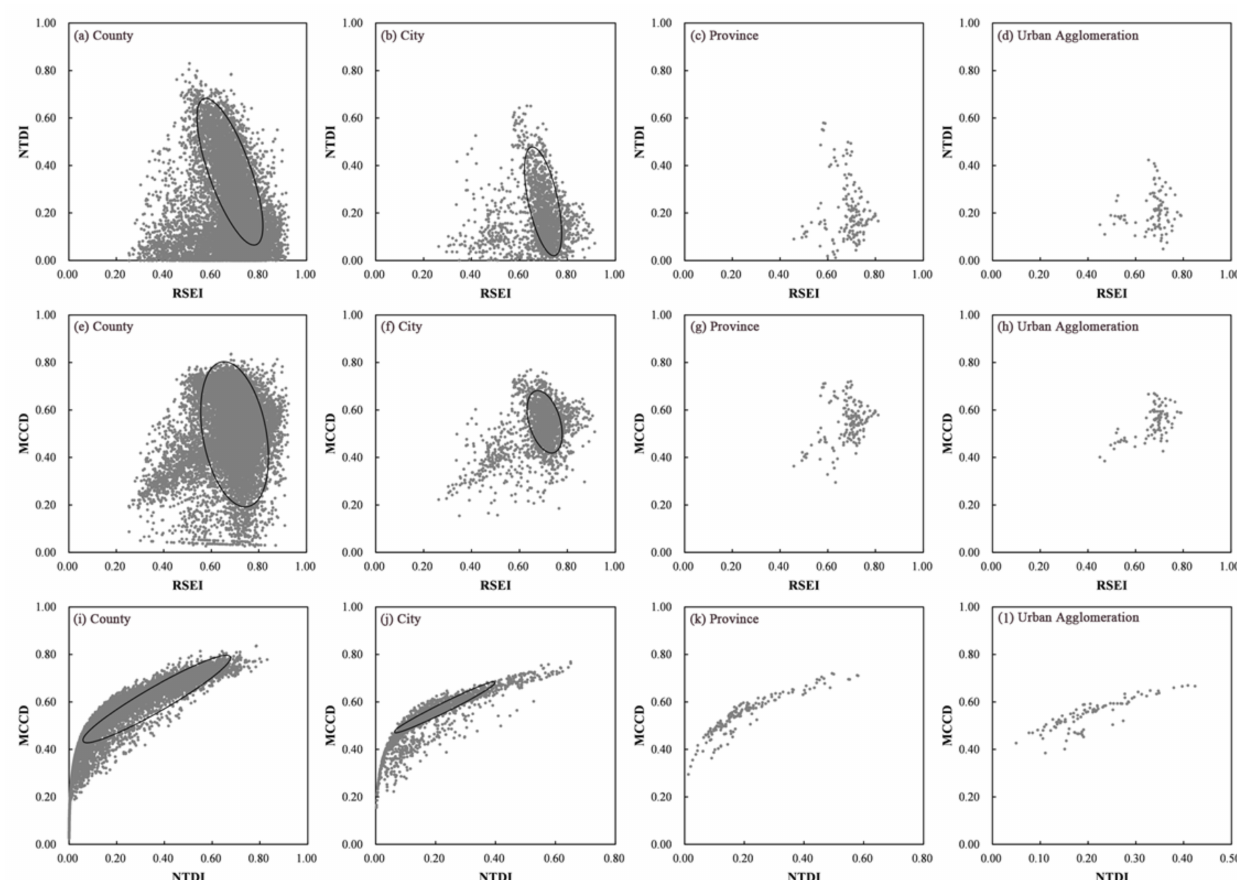
Figure 10. Scatter plots of any two sets of the RSEI, NTDI and MCCD at different scales.